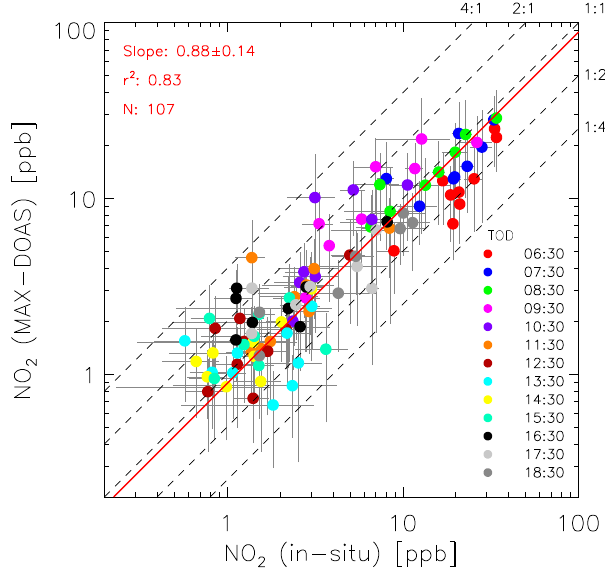
Fig. 8. Comparison of NO 2 mixing ratios measured by MAX- DOAS and in-situ chemiluminescence technique during the PRIDE- PRD2006 campaign. Data displayed here are obtained on the 9 cloud-free days. The regression line is forced through the